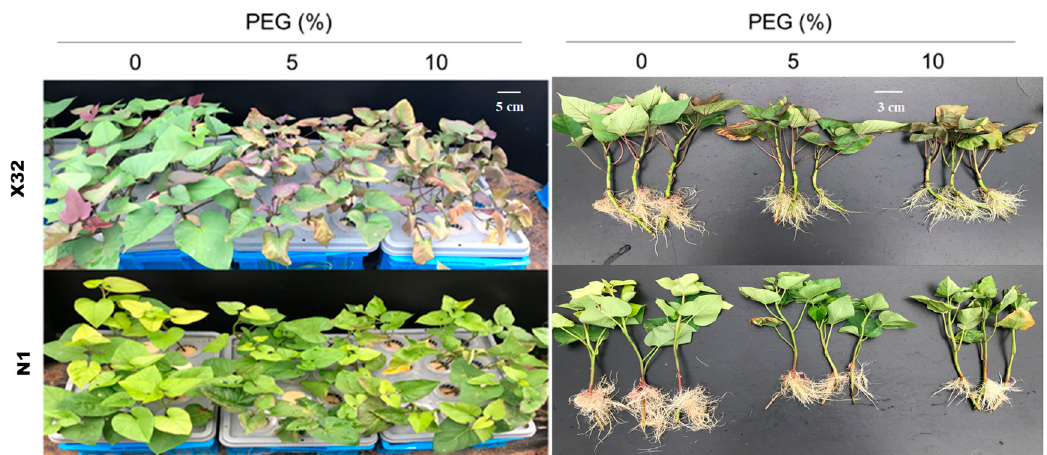
Figure 3. Effect of PEG ‐ induced drought stress on plant growth and development in the sweet potato. Each treatment consisted of five pots, each containing twelve plants. X32 and N1 represent Xushu 32 and Ningzishu 1, respectively.